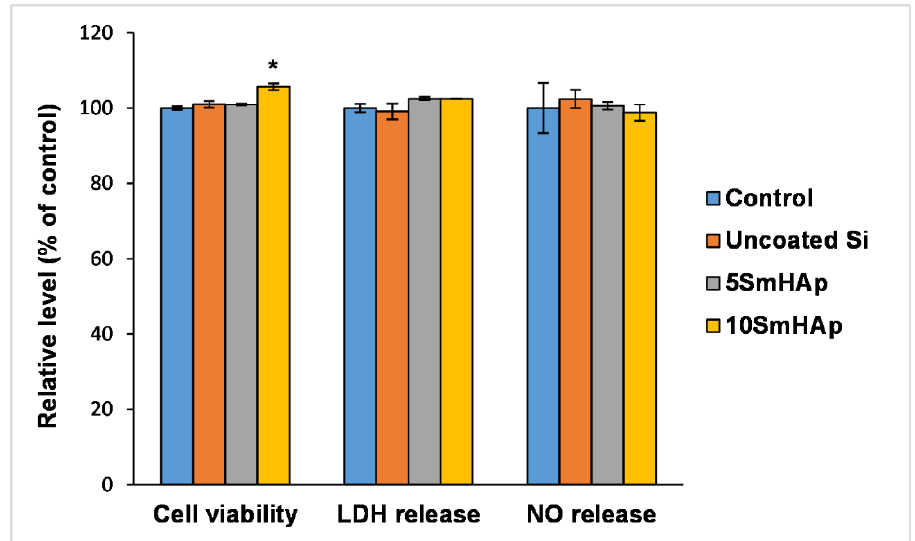
Figure 7. Biocompatibility of uncoated Si substrates and different samarium doped hydroxyapatite coatings as shown by cell viability, lactate dehydrogenase (LDH), and nitric oxide (NO) release assays after 24 h exposure on normal gingival fibroblasts. Results are expressed as the mean ± standard deviation (SD) ( n = 3) and represented relative to the untreated cells (control). * p < 0.05 compared to control.